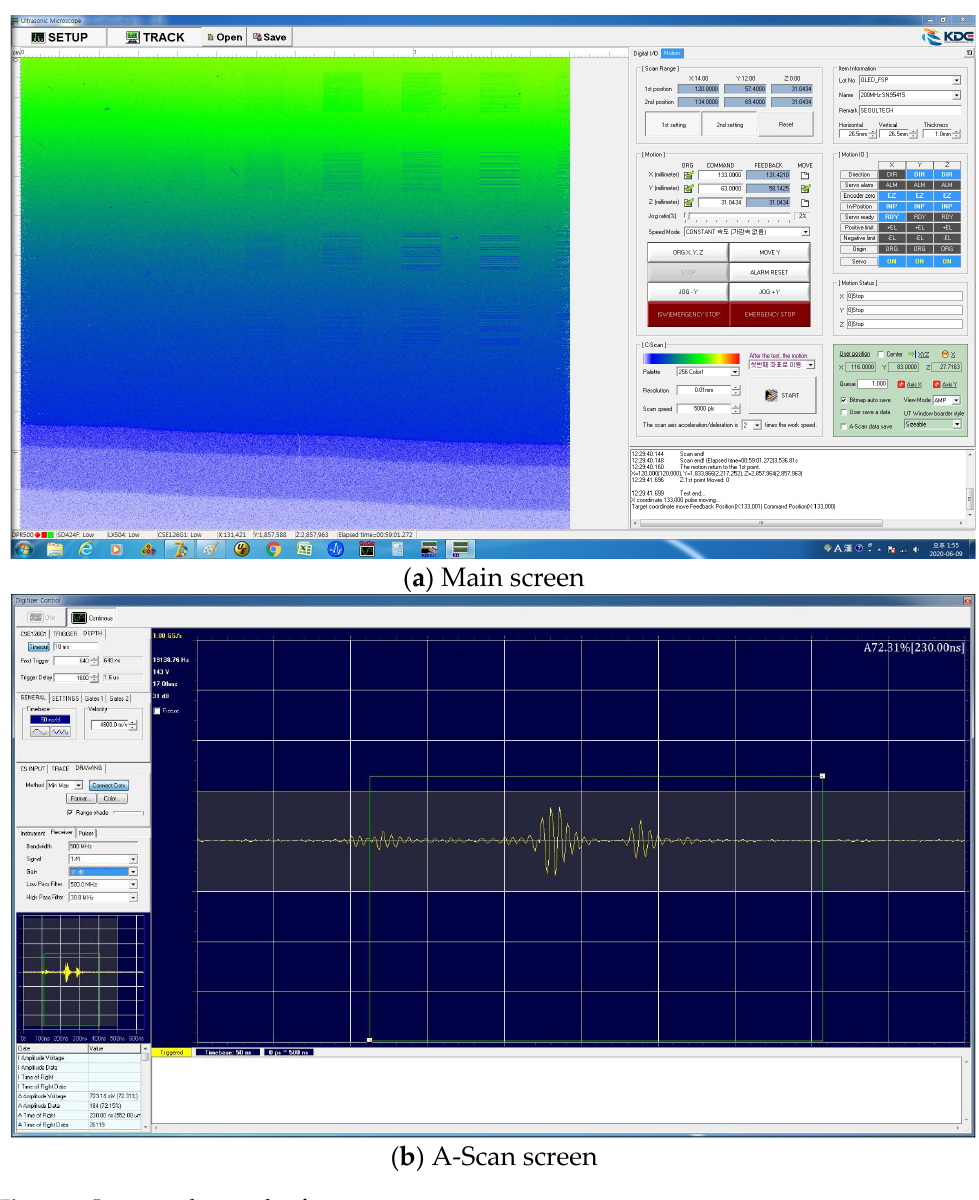
Figure 8. Integrated control software.